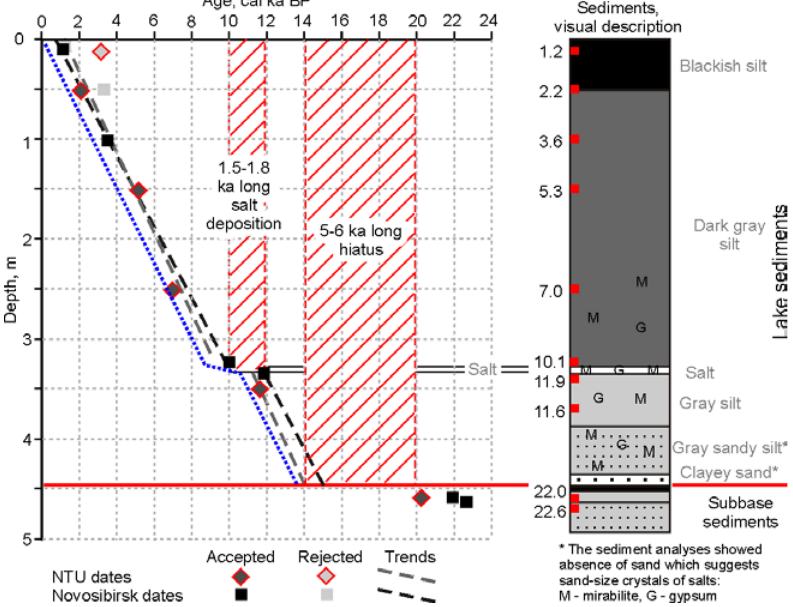
Figure 4. Schematic 14 C-data indicating interruptive sedimentation and sediments visual description.